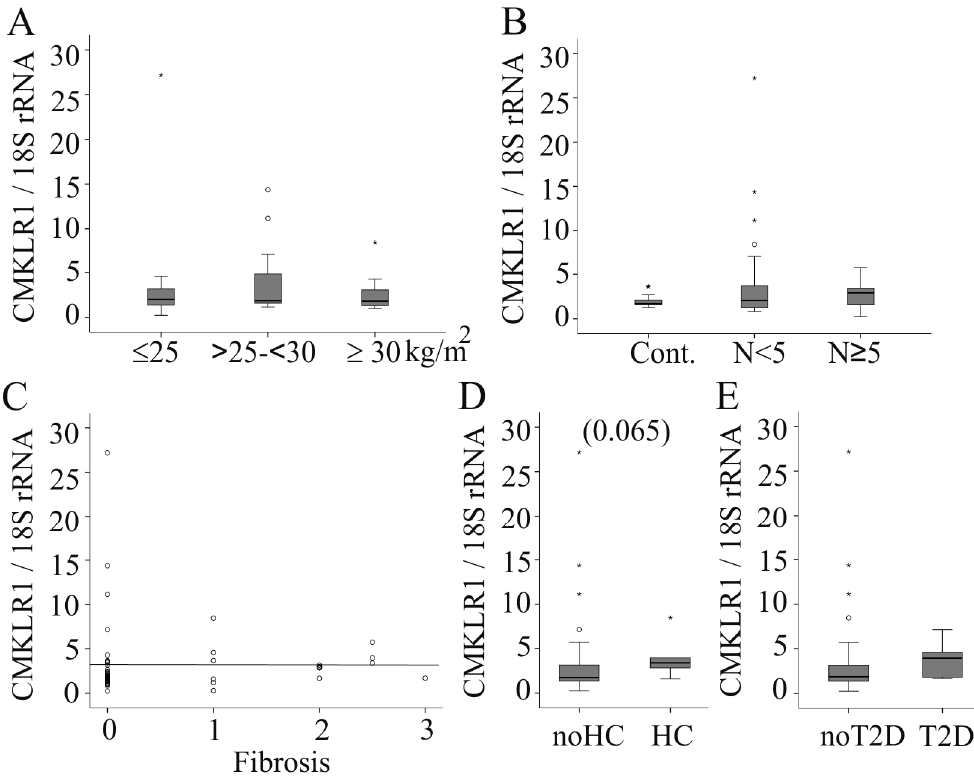
Figure 3. CMKLR1 mRNA (normalized for 18S rRNA) in female NAFLD patients. ( A ) CMKLR1 mRNA in the liver of normal-weight (BMI ≤ 25 kg/m 2 ), overweight (BMI > 25 and < 30 kg/m 2 ) and obese (BMI ≥ 30 kg/m 2 ) female patients; ( B ) CMKLR1 mRNA in liver tissues of female patients with healthy liver (Cont.), a NASH score ( N ) <5 and ≥ 5; ( C ) Correlation of hepatic CMKLR1 mRNA in females with fibrosis; ( D ) Hepatic CMKLR1 in females with and without hypercholesterolemia (HC); ( E ) CMKLR1 mRNA in liver tissues of female patients with and without type 2 diabetes (T2D). Number in brackets indicates a trend.